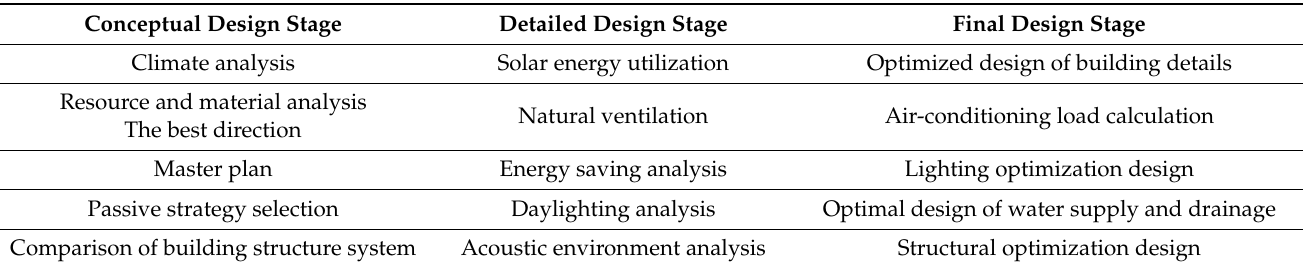
Figure 28. Standard operating procedures (SOP) for energy consumption simulation based on BIM. Table 5. BIM-based simulation focusing on various design